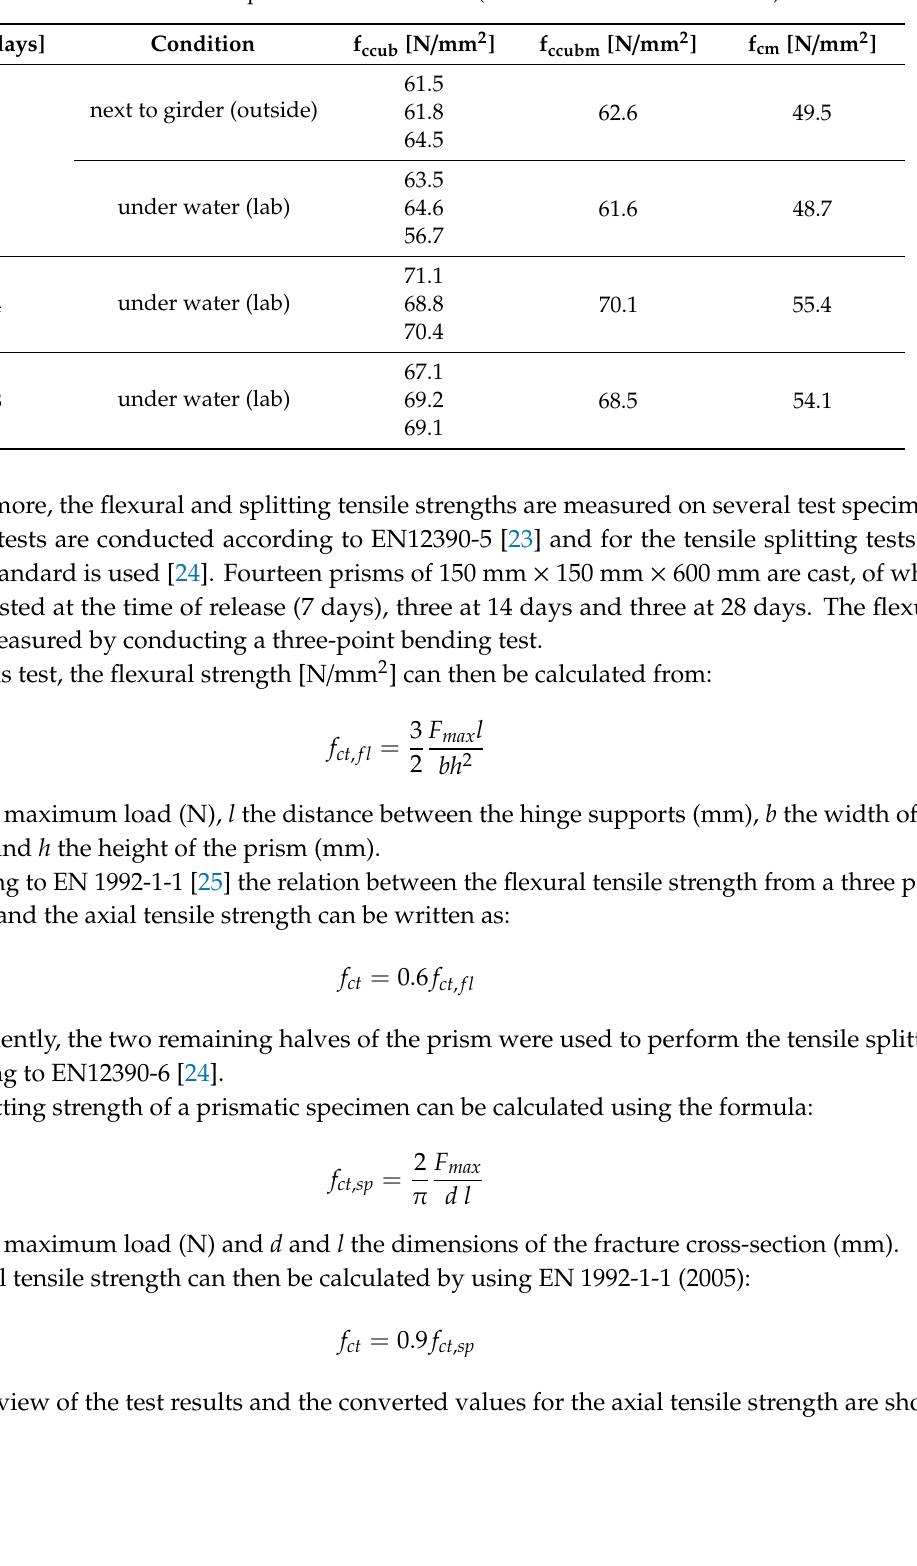
Table 2. Concrete compressive tests on cubes (150 mm × 150 mm × 150